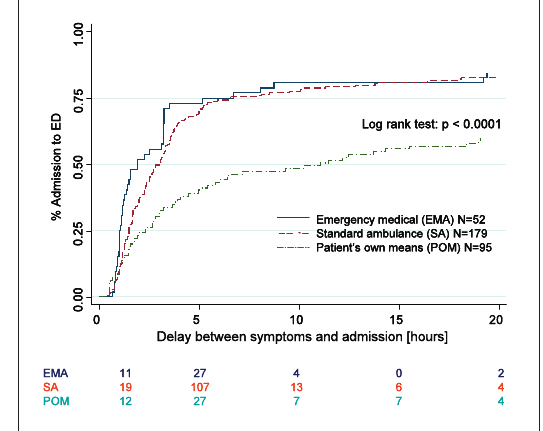
Kaplan-Meyer curves of admission delays between first symp- toms and admission to the emergency de- partment (ED): differ- ences between the kinds of transporta- tion (computed on the full data set, but focused on the first 24 hours). Absolute number of patients is shown below the x-